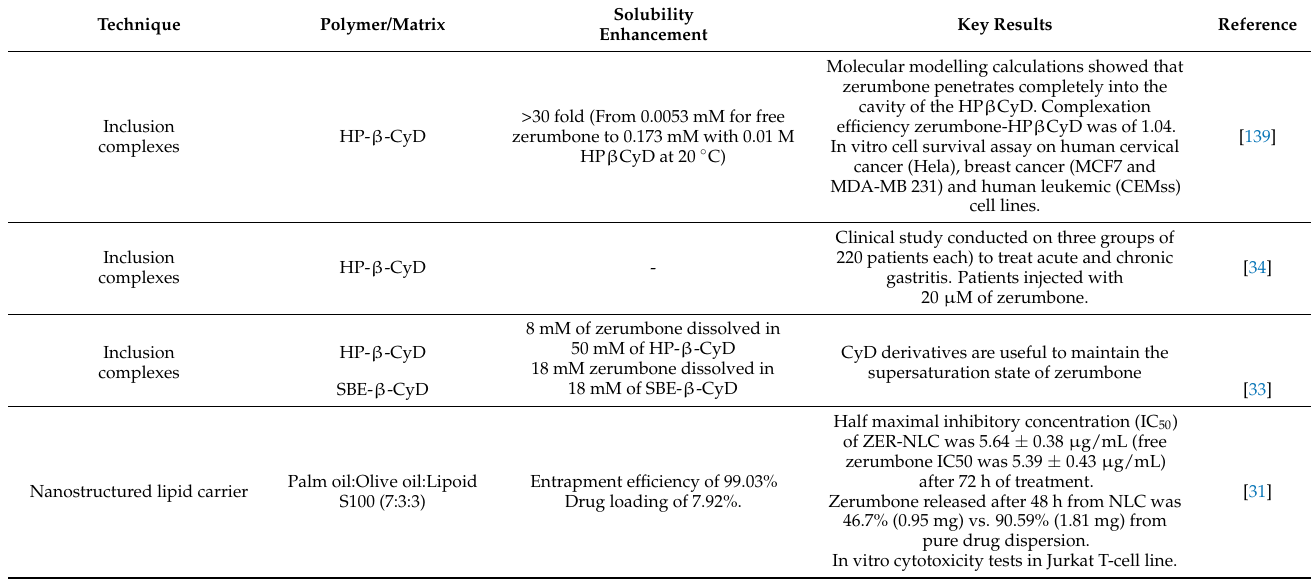
Table 2. Additional information on the studies reviewed in this